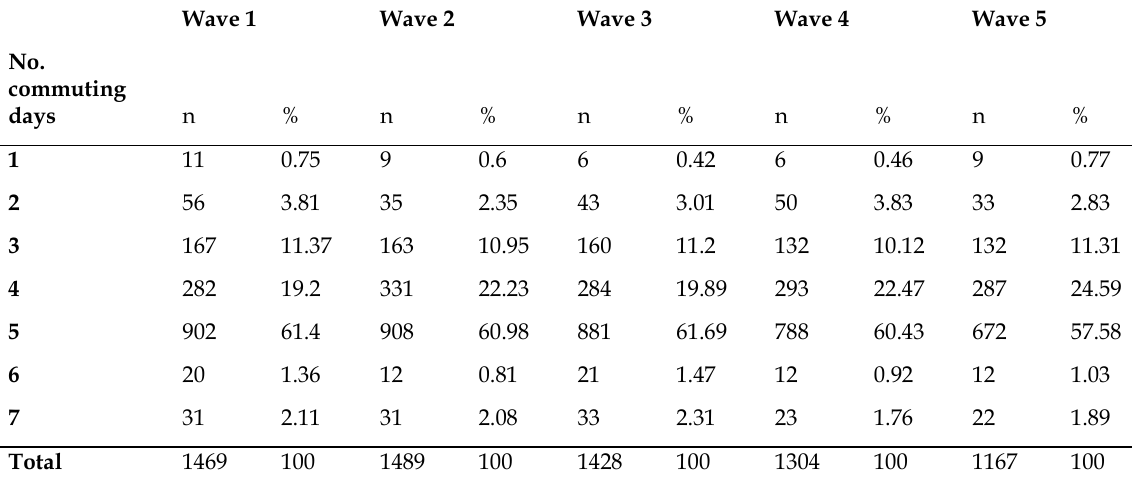
Table 4. Number of days travelled to work Wave 1 Wave 2 Wave 3 Wave 4 Wave 5